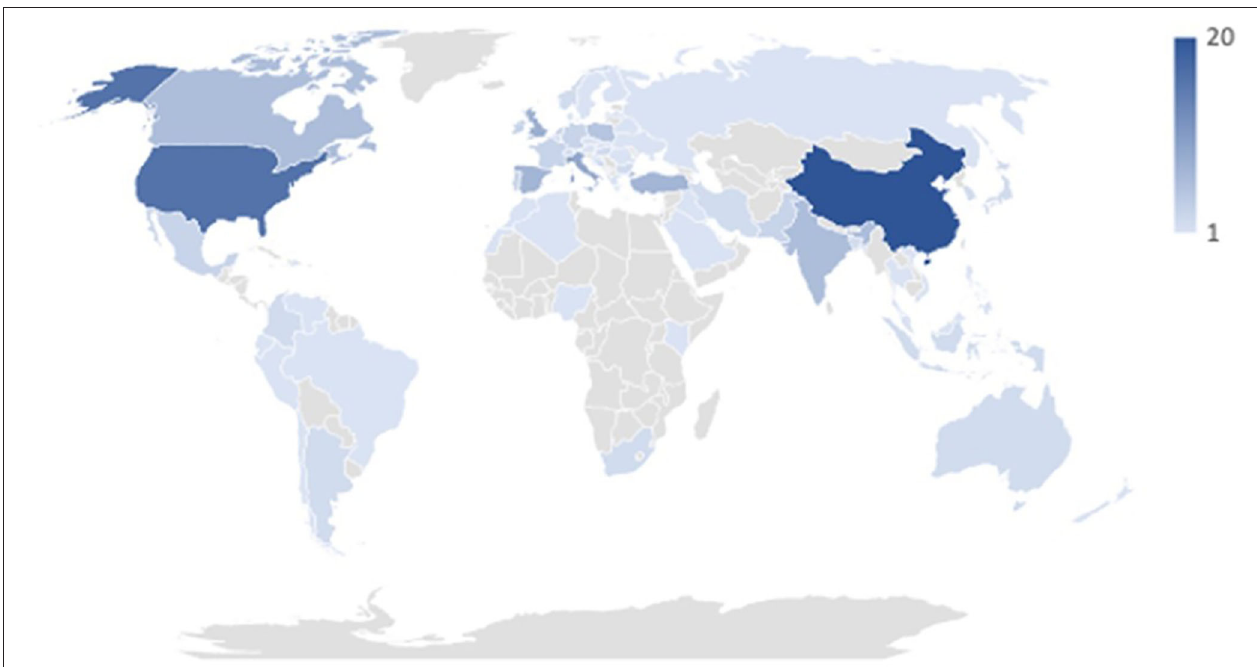
FIGURE 2 | Number of countries included in the